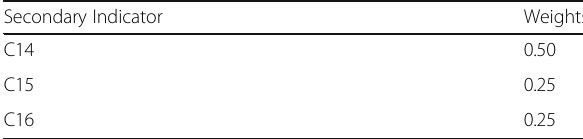
Table 14 Weight of secondary indicator under “ Cooperation and Relationship ” . (Source: Authors)